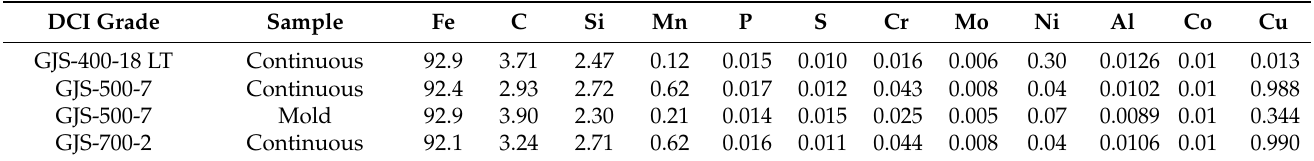
Table 1. Chemical composition of the examined alloys of DCI in weight percent.